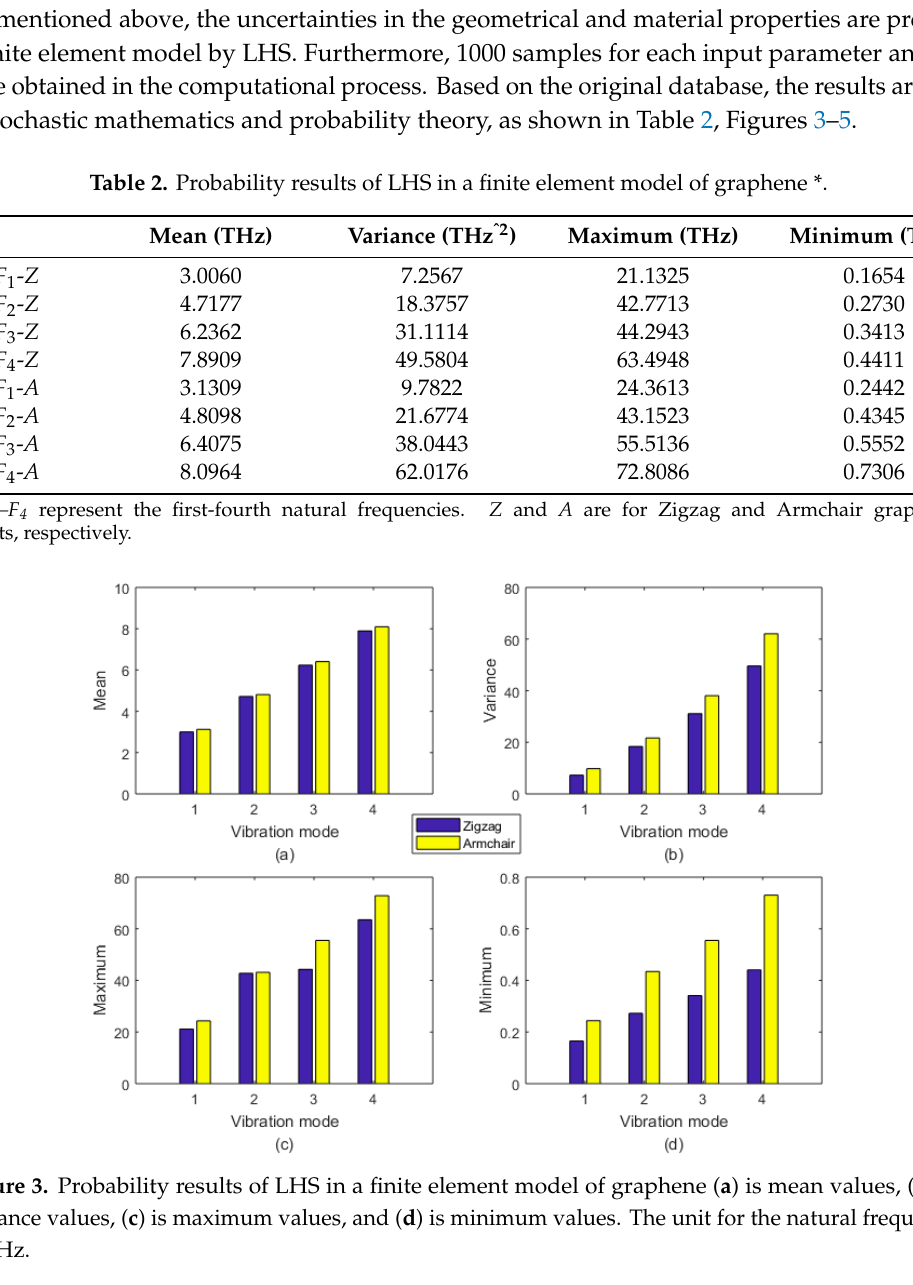
Figure 3. Probability results of LHS in a finite element model of graphene ( a ) is mean values, ( b ) is variance values, ( c ) is maximum values, and ( d ) is minimum values. The unit for the natural frequency is THz.